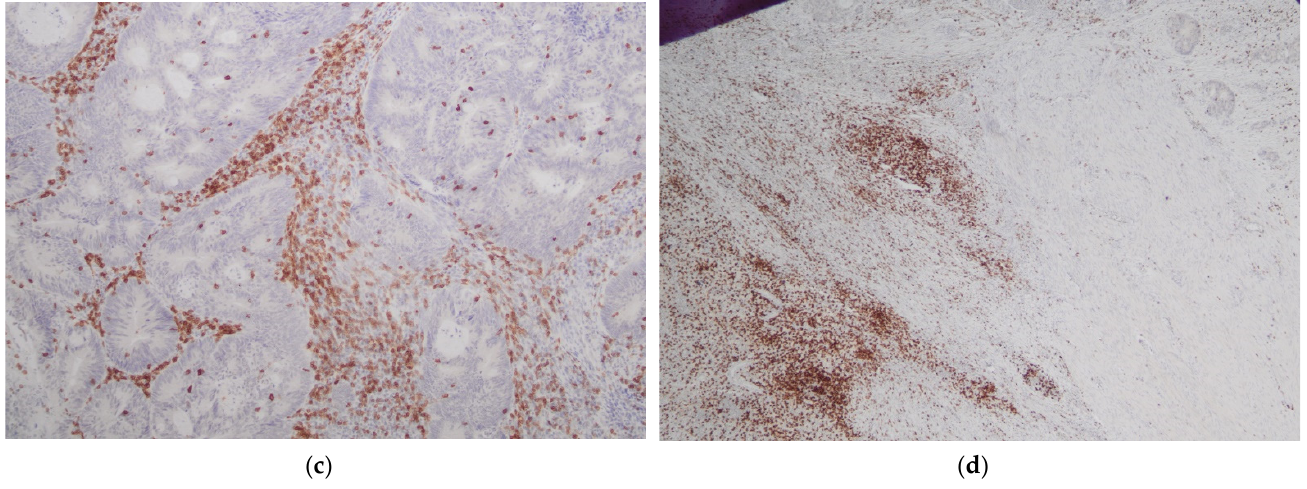
Figure 2. Intense lymphocyte infiltrates in tumor center (CT) ( a , c ) and tumor margin (IM) ( b , d ). H&E staining ×40 ( a ); H&E staining ×100 ( b ) ; CD3 staining ×100 ( c , d ).